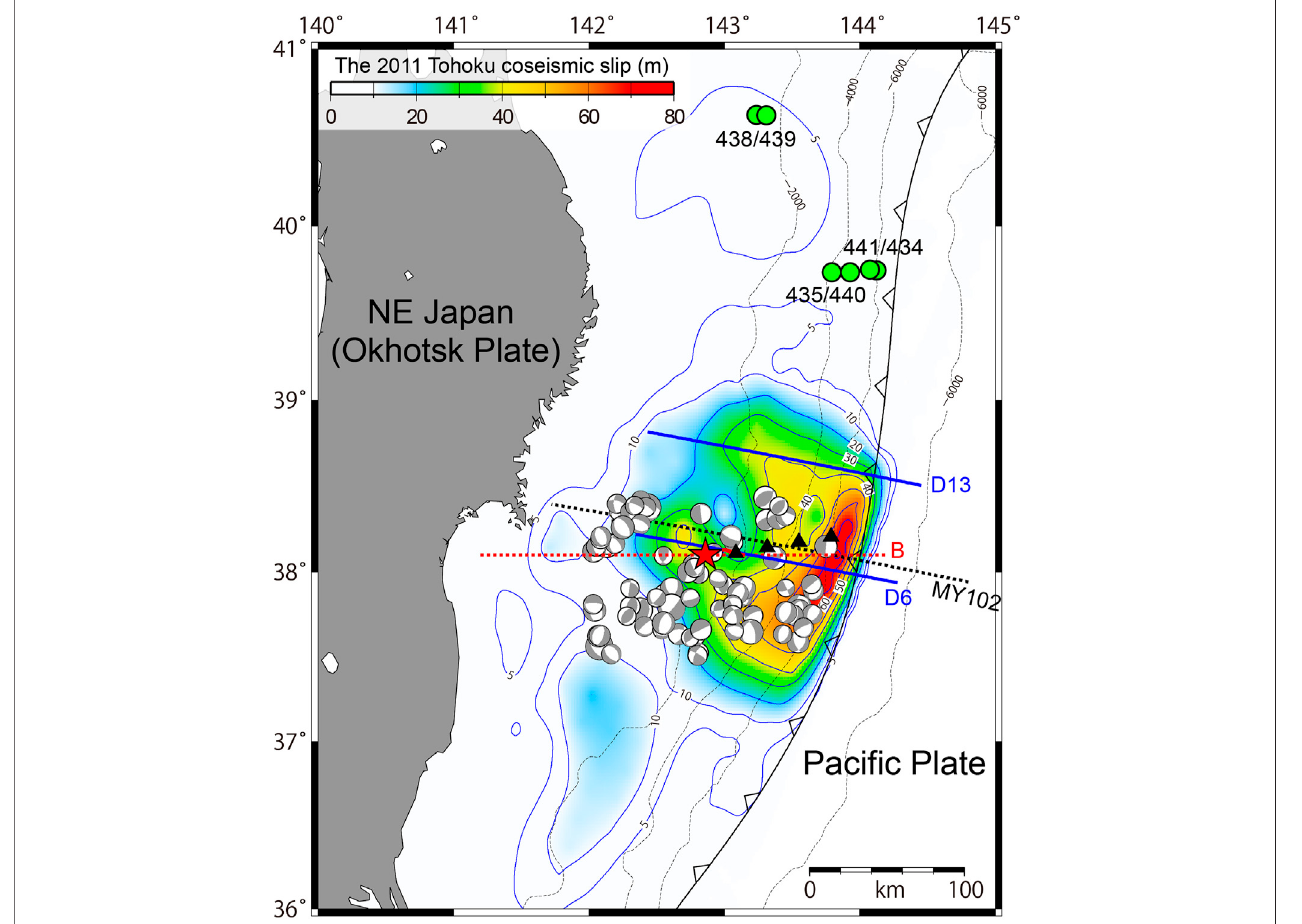
FIGURE 1 | Bathymetry map of the Japan Trench margin off northeast Japan. The Paci fi c plate subducts beneath the Okhotsk plate (northeast Japan) at a convergence rate of 8.6 cm/yr (DeMets et al., 1990). Heavy blue, black dotted, and red dotted lines respectively mark MCS lines D6 and D13 (this study), OBS line MY102(Miuraetal.,2005),andseismictomographylineB(LiuandZhao,2018).Fourblacktrianglesmarkheliumisotopeanomalysites(Sanoetal.,2014):sitesN3,N2, N1,andRfromwesttoeast.The2011Tohoku(M w 9.0)coseismicslipmodelwithcolorsandthinbluecontoursisgivenbyIinumaetal.(2012).Theredstardenotes themainshock epicenterofthe2011Tohokuearthquake. Centroidmoment tensors(CMTs) foraftershocksofthe2011Tohokueventwithintheoverlying Okhotskplate (Asano et al., 2011) are displayed around the MCS and OBS lines. Green circles show DSDP site numbers of 434 – 441 (Nasu et al., 1980).